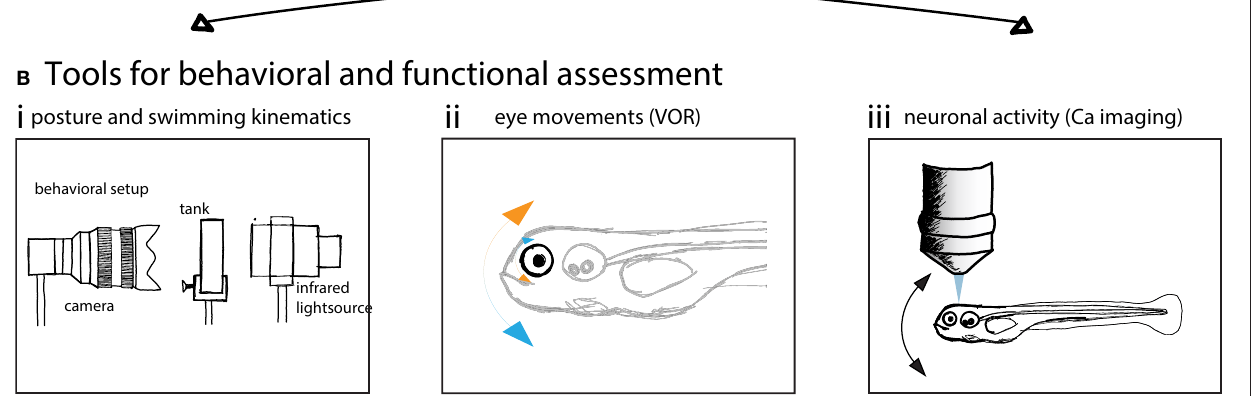
FIGURE 3 | Zebrafish larvae are well suited to assess behavior and neuronal circuit function after myelin manipulations. (A) Schematics of possible manipulations that can be performed using zebrafish as a model system. (i) 2 Photon laser ablation can be used to selectively demyelinate and create focal myelin lesions. (ii) The development of myelination can be accelerated or delayed using pharmacological treatments. (iii) Optogenetic methods can be used to probe circuit function. (B) Schematics of methods used to assess vestibular behavior and circuit function. (i) Posture and swimming kinematics can be analyzed. (ii) Vestibulo-ocular reflex can be tested and compensatory eye movements analyzed. (iii) Calcium imaging can be used to measure neural activity to assess circuit